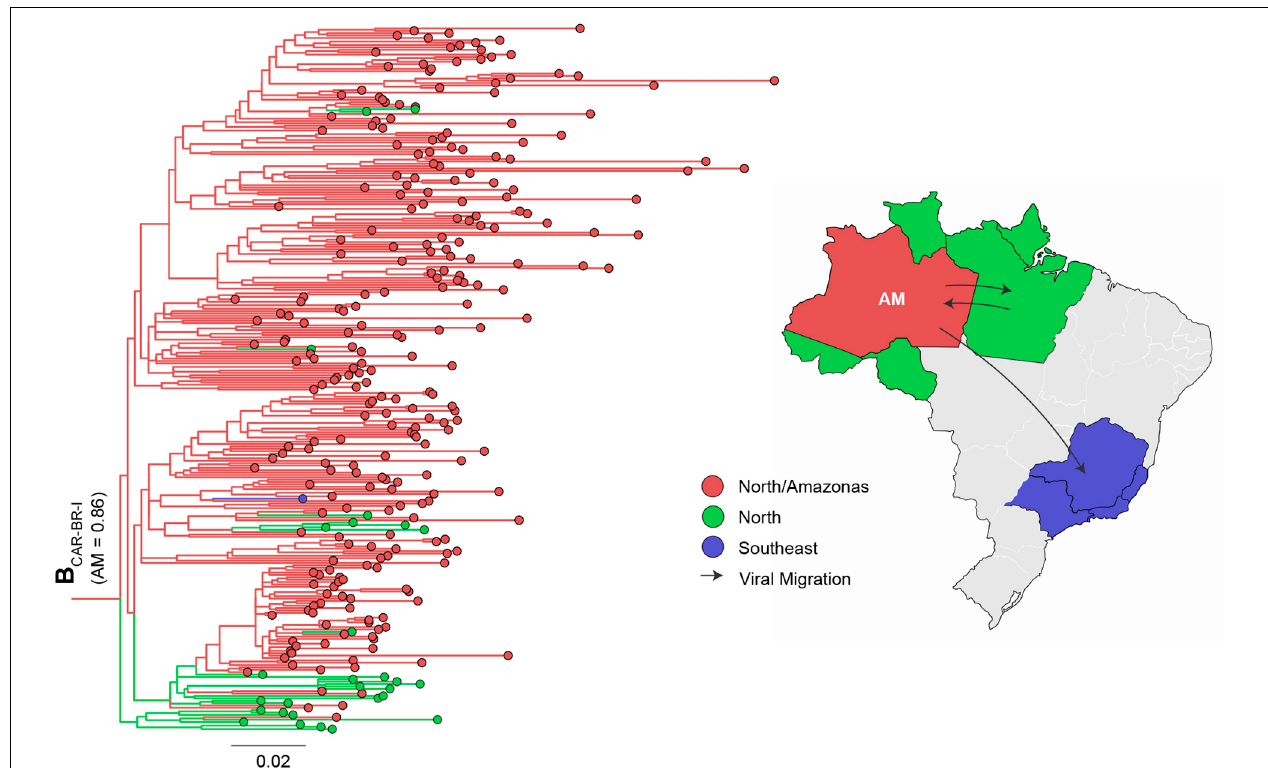
FIGURE 1 | ML phylogeographic analysis of major cluster B CAR − BR − I disseminated in Brazil. A total of 296 B CAR − BR − I Brazilian sequences sampled in Amazonas ( n = 267) and other states ( n = 29) were analyzed. The number in parenthesis indicates the inferred marginal probability that the clade ancestor was located in the Amazonas state. The location of taxonomic units at internal nodes across the ML tree was reconstructed and represented according to the color scheme shown in the map. Outside Amazonas state, other Brazilian units were aggregated according to the country region. AM, Amazonas; N, North; SE, Southeast. The tree was rooted using HIV-1 subtype D reference sequences (not shown). The branch lengths are drawn to scale with the bar at the bottom indicating nucleotide substitutions per site. Major migrations of viral clade B CAR − BR − I are represented in the